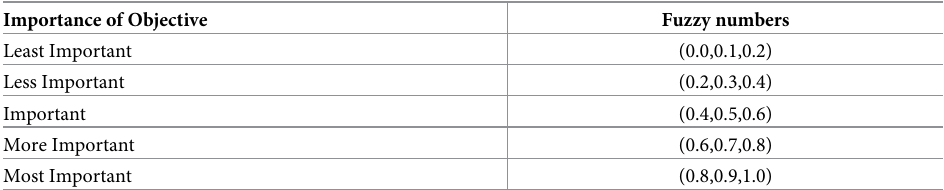
Table 6. Fuzzy linguistic